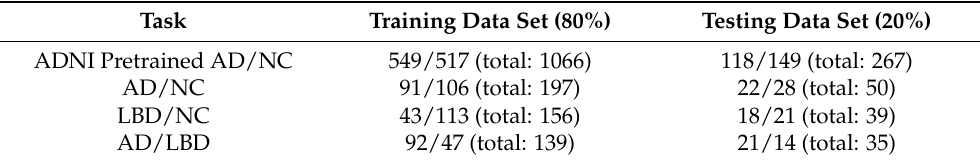
Table 3. The number and class distribution of all classification tasks in training and testing data